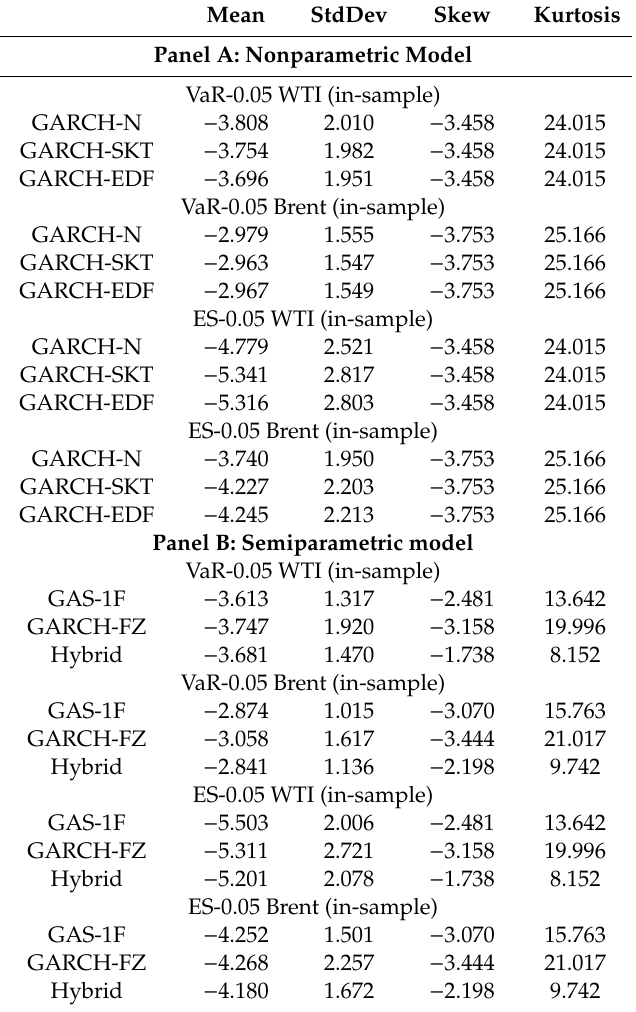
Table 3. Descriptive statistics for the WTI and Brent crude oil value-at-risk (VaR) and expected shortfall (ES). Mean StdDev Skew Kurtosis Panel A: Nonparametric Model VaR-0.05 WTI (in-sample) GARCH-N −